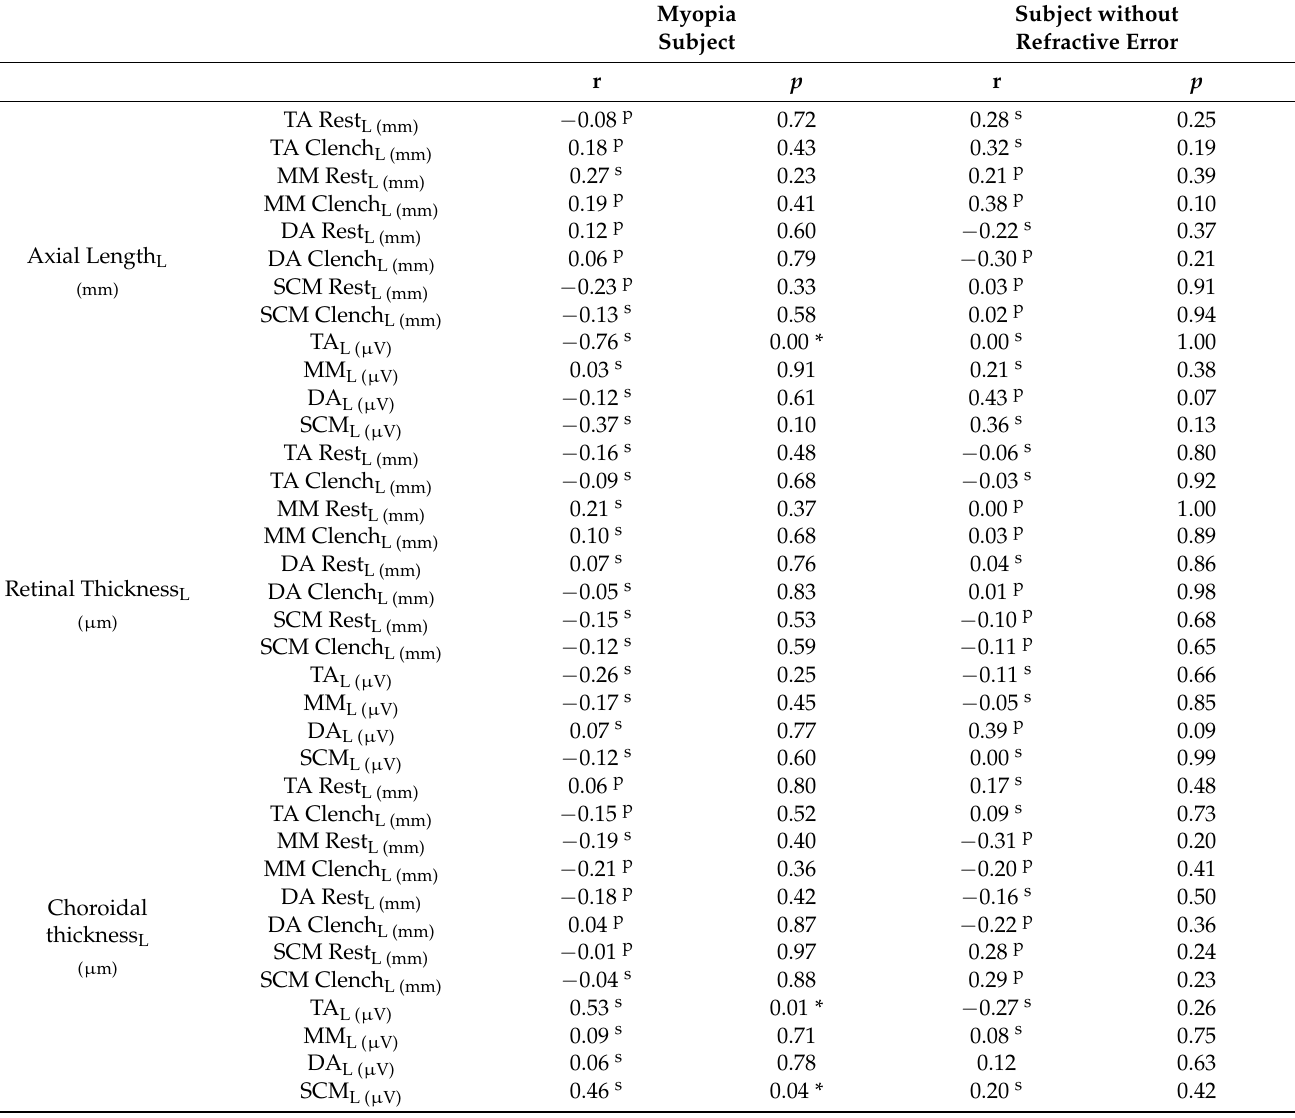
Table 4. Presentation of the resulting left-hand correlations between